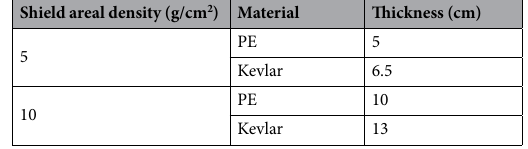
Table 3. Thickness of the